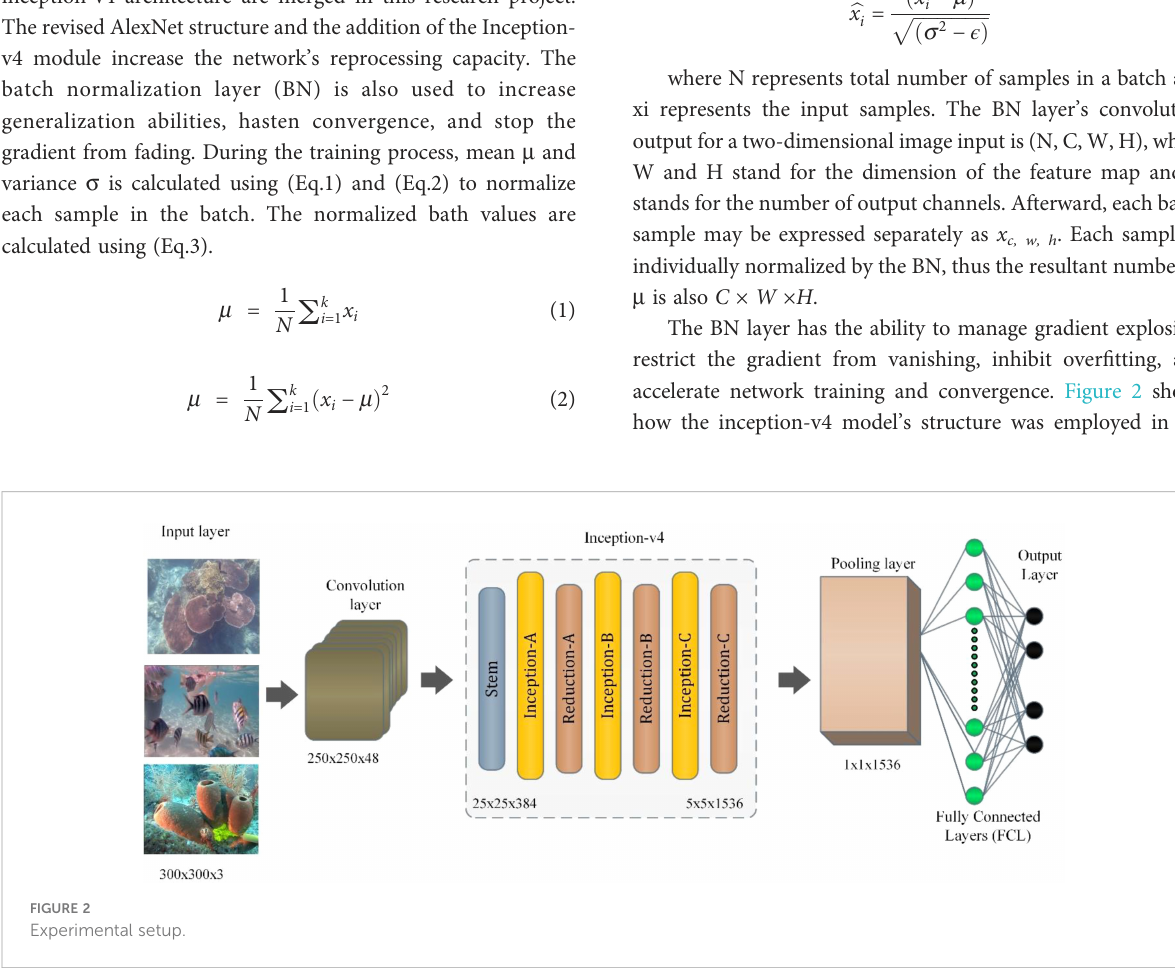
FIGURE 1 Different data fusion